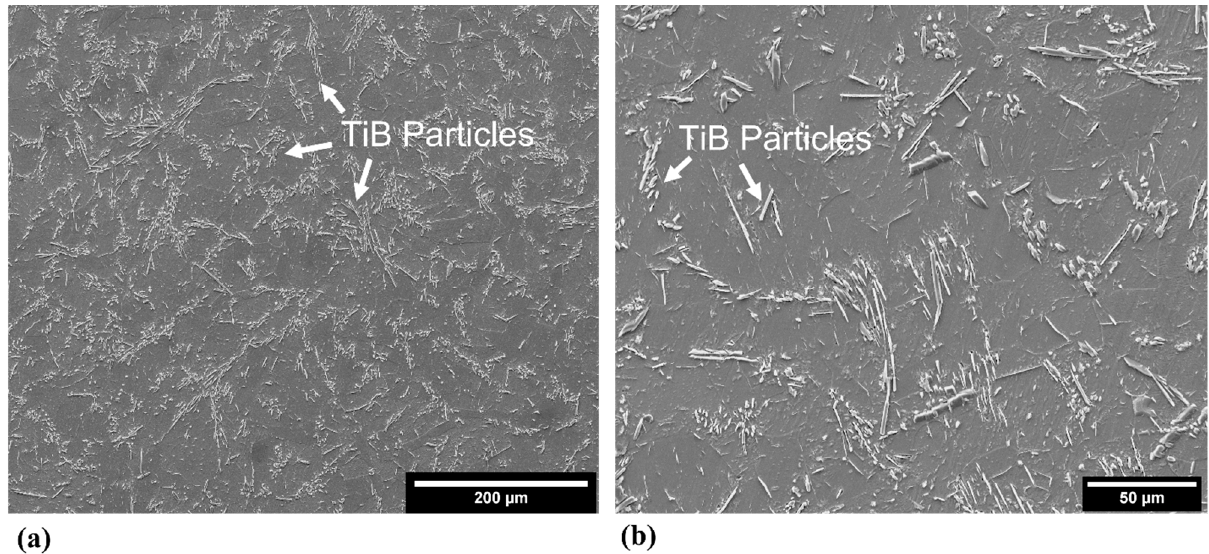
Figure 3. ( a ) Secondary electron (SE)-SEM image highlighting the typical microstructure of PTA-SFFF samples studied in this research, etched using Kroll’s reagent, which features alpha ( α ) grain Ti with needlelike TiB particles. ( b ) Higher magnification image of the etched microstructure, representatively highlighting the untreated subsurface of the samples.